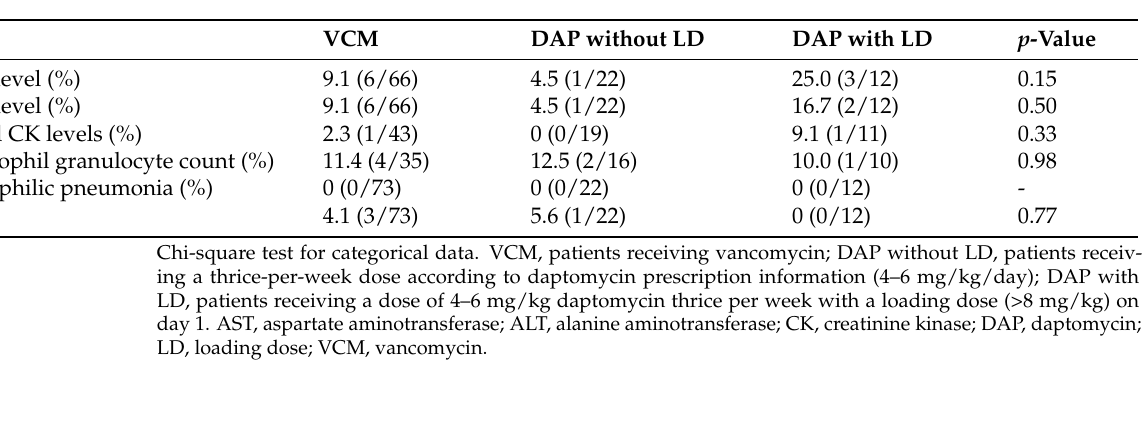
Table 6. Safety data of patients receiving vancomycin and daptomycin treatments with or without a loading